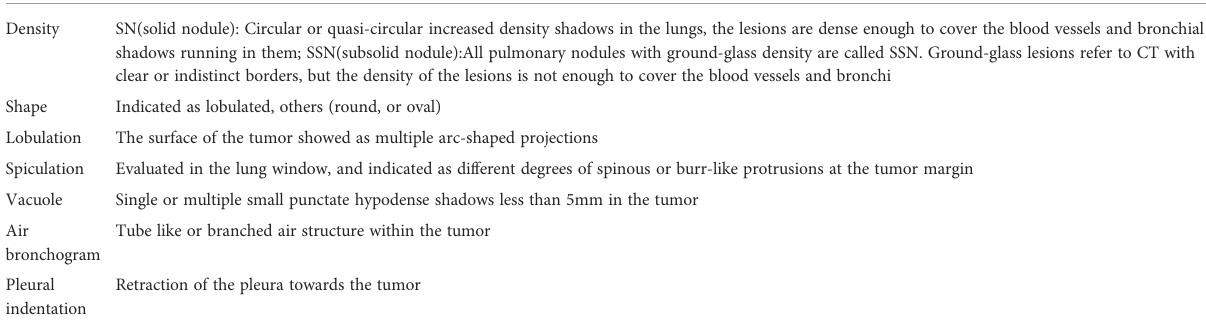
TABLE 1 CT features for lung